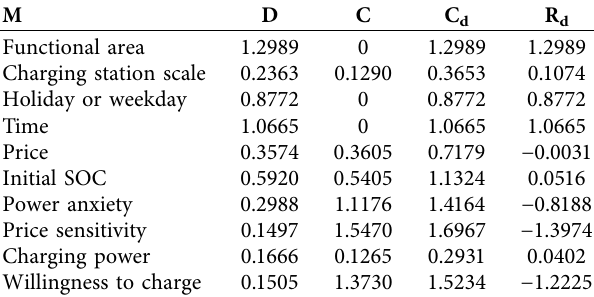
Table 2: Evaluation index of each factor in the integrated